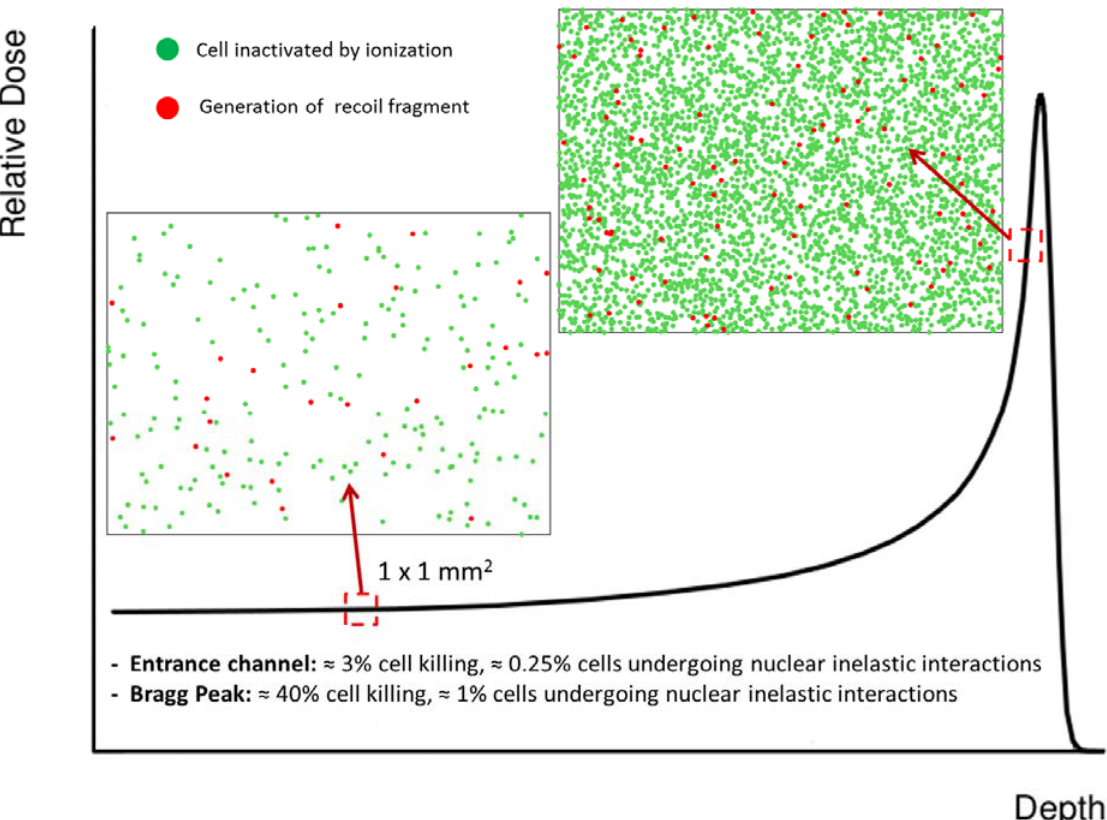
Figure 5. The figure schematically shows the impact of ionization and target fragmentation in tissue sections of 1 × 1 mm 2 . The effect is considered at two different positions along the depth-dose profile. The LEM code was used to estimate cell survival probability [14,15]. The expected contribution of target fragments is calculated assuming that in water about 1% of primary protons undergo nuclear inelastic interactions per traversed cm. We chose a fluence of 2.5 × 10 8 p/cm 2 for the primary beam, and assumed that cell nuclei cover an area of ≈ 100 μ m 2 . This means that we can expect an average of 250 particles traversing a nucleus. When following protons traversing 1 mm of tissue (stack of 100 cells), we thus expect an average of 0.25 protons undergoing inelastic nuclear reactions. In other words, we will have one fragmentation event every fourth stack of cells, which translates to what is shown in the figure. Importantly, we only show cells where target fragments are generated, but a fraction of those fragments might have enough energy to traverse a few cell nuclei before coming to rest. This is true especially for light fragments (see also Table 1). Even though both the contributions of ionization and fragmentation increase when approaching the Bragg peak, at that position the biological effect is mainly due to ionization events. On the contrary, in the entrance channel the predicted survival is high, and therefore a significant role might be played by low-energy target